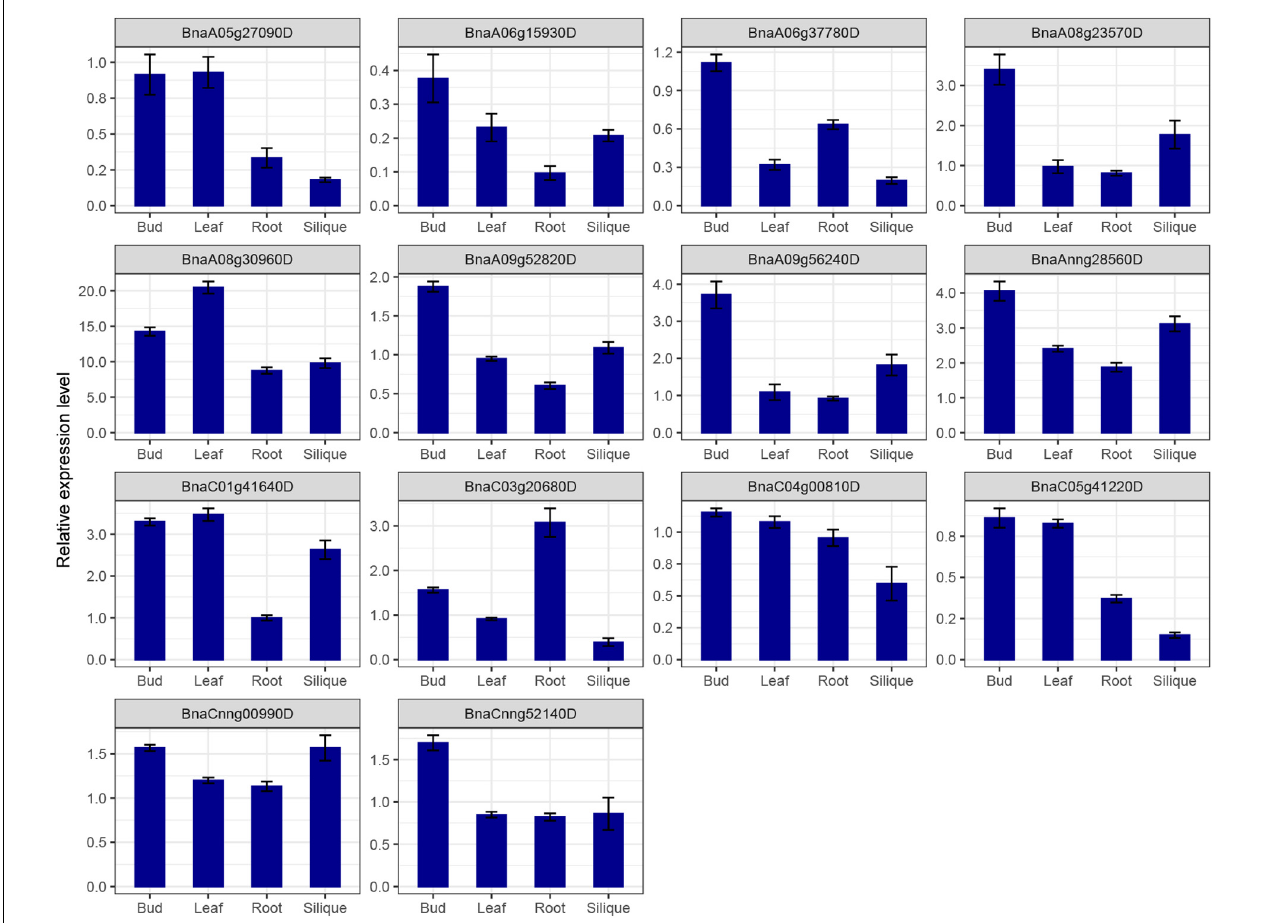
FIGURE 7 | qRT-PCR expression analysis of 14 SR genes in different tissues of B. napus . The error bars represented the standard error of the means of three